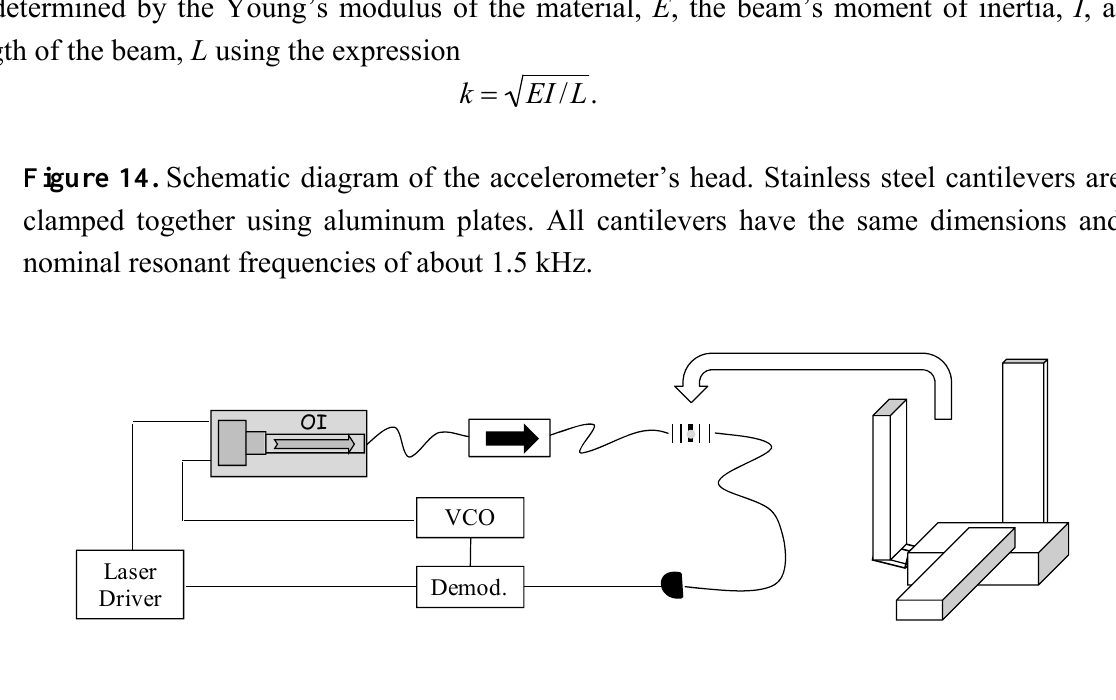
Figure 15. Pound-Drever-Hall error signal obtained by 60 MHz demodulation of the reflected field from a PS